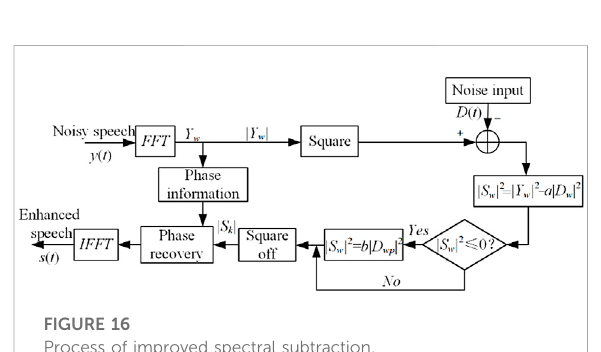
FIGURE 17 Changes of audible signals before and after